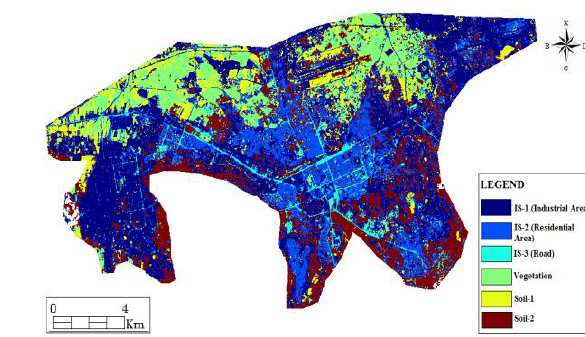
Figure 5: The thematic map produced via classification of